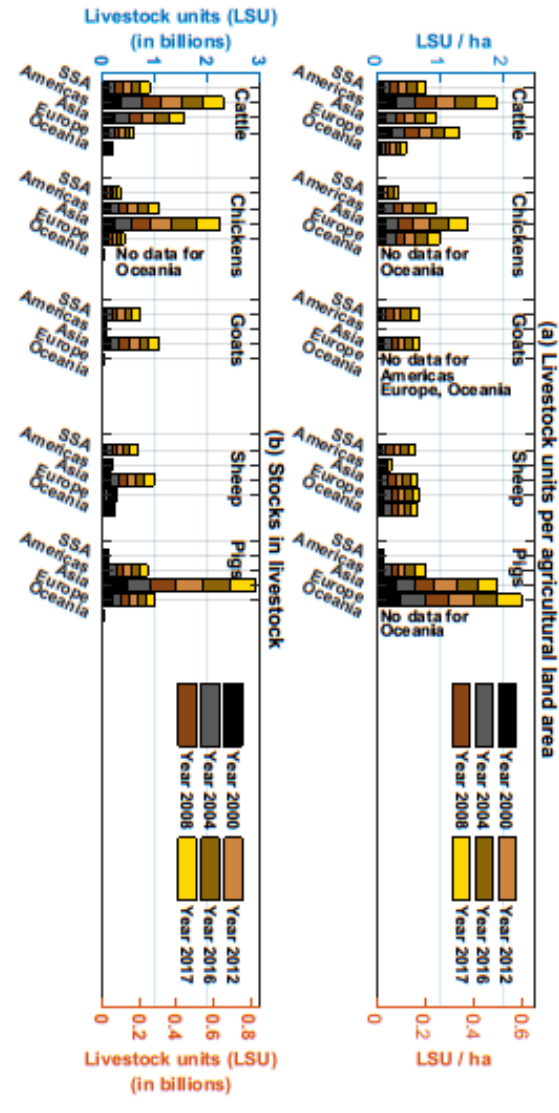
Figure 3. Livestock patterns across global regions from 2000 to